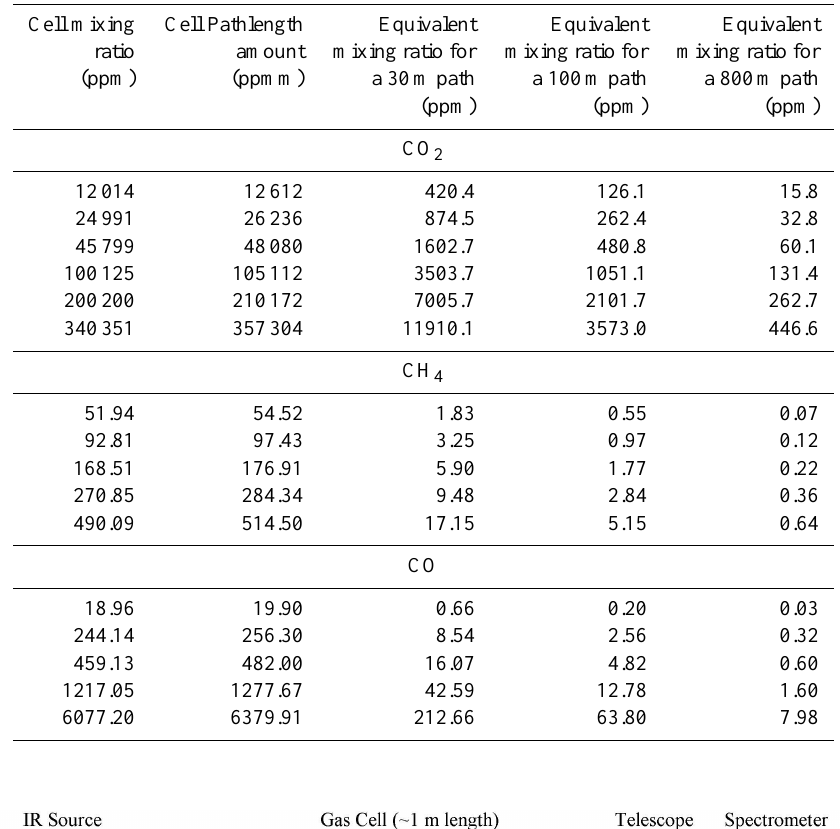
Table 1. Cell mixing ratios (ppm) and equivalent pathlength amounts (ppmm) for the 1.05m gas cell filled with CO 2 , CH 4 and CO respec- tively, with the equivalent mixing ratios for longer atmospheric paths (assuming the same temperature, ∼ 20 ◦ C, and pressure, ∼ 1000hPa conditions) also given. For reference, ambient “clean” air mixing ratios of CO 2 , CH 4 and CO are circa 385ppm, 1.8ppm and 0.15ppm, respectively.